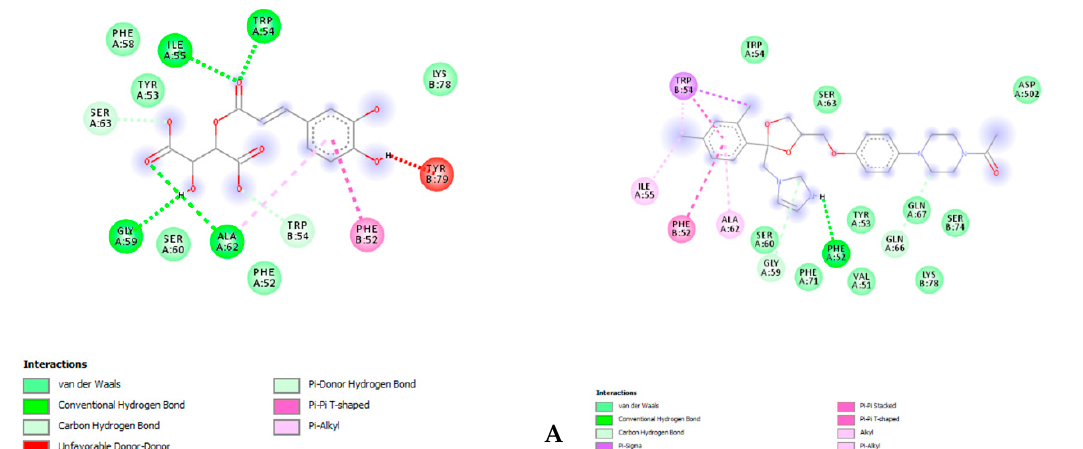
Figure 3. HPLC–DAD-MS analysis of methanolic extracts from B. pilosa plant materials. Among identified phenolic com- pounds in Table 1, caftaric acid (peak #3), catechin (peak #4), chlorogenic acid (peak #5) and epicatechin (peak #6) were identified in the whole plant ( A ), stem ( B ) and root ( C ). In the leaf ( D ), the principal phenolics identified in the extract were: gallic acid (peak #1), chlorogenic acid (peak #2) and epicatechin (peak #3).